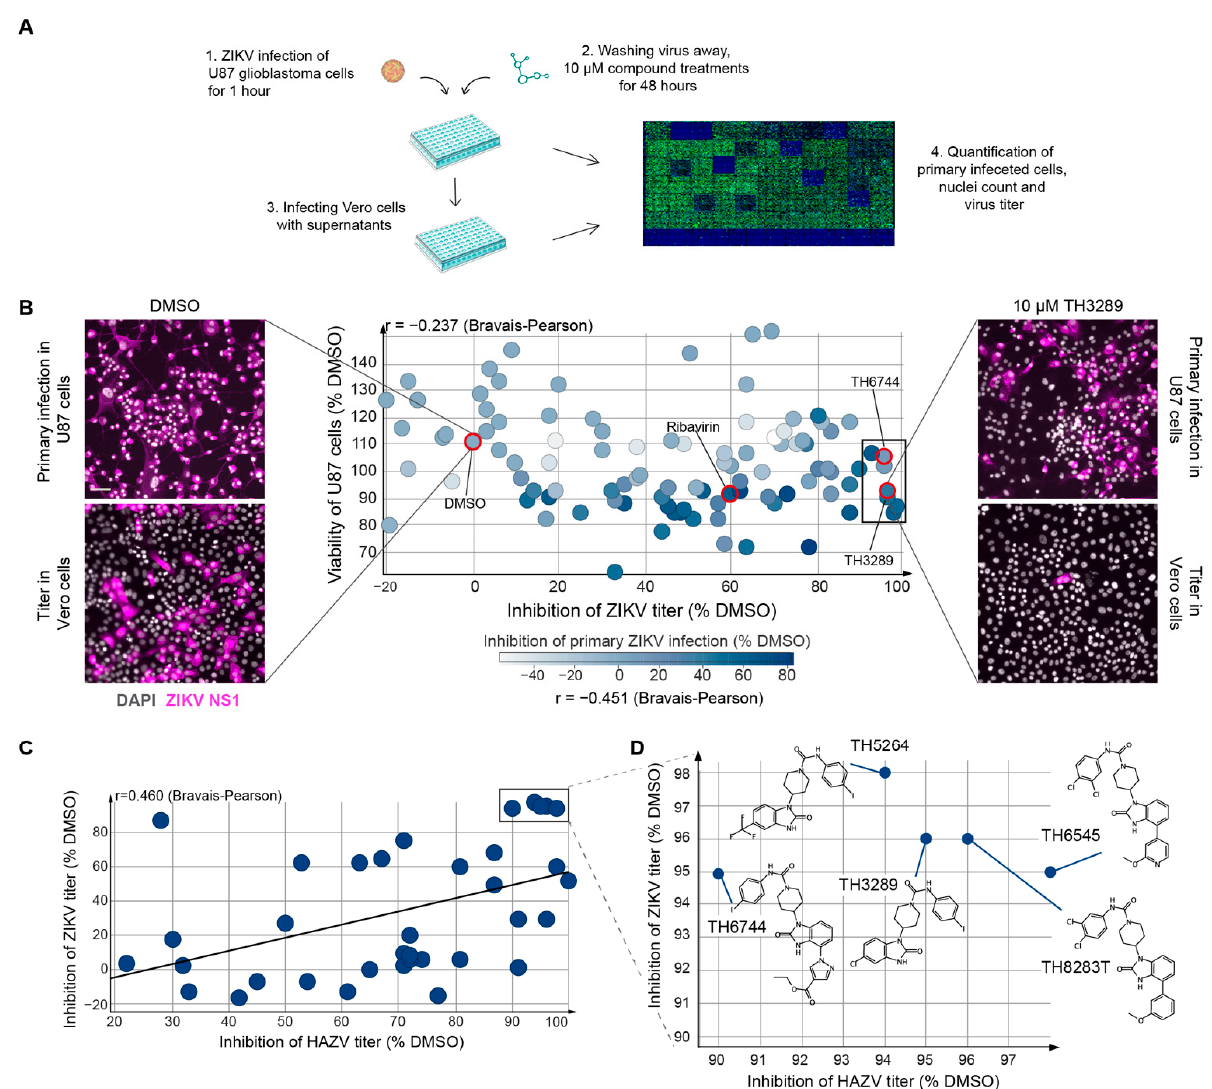
Figure 1. Image-based screening on Zika virus (ZIKV)-infected cells identifies TH3289 and TH6744 as active small molecule inhibitors against ZIKV. ( A ) Experimental workflow of phenotypic antiviral testing of small molecule compounds. Nuclei count was used as an indicator of cytotoxicity, viral antibody staining was quantified to assess the percentage of virus infected cells and virus titer was quantified by end-point dilution assay. ( B ) U87 cells were infected with ZIKV (MOI 10) and treated with structural analogs of TH3289 at 10 µ M concentration for 48 h. Infected cells were stained for DAPI and ZIKV NS1 and analyzed by high-throughput imaging. Virus titers from supernatants were determined by end-point dilution assay and inhibition of viral titer was calculated relative to dimethyl sulfoxide (DMSO). Data are presented as a mean of two technical replicates per compound performed in n = 1 biological replicate. Representative images from ZIKV-infected U87 cells treated with DMSO or TH3289 (upper image panels; Scale bar equals 100 μ m) and corresponding example of titrated ZIKV from the end-point dilution assay (lower image panels) are shown. DAPI in grey, ZIKV NS-1 in magenta. ( C ) The inhibition of viral titers of Hazara virus (HAZV) and ZIKV from both assays was correlated. In the HAZV assay, SW13 cells were infected with HAZV (MOI 10) and treated with 10 μ M of compounds from the in-house library for 24 h. Virus titer from supernatant was determined by end-point dilution assay. Cells were stained for DAPI (in blue) and HAZV NP (in green) and analyzed by high-throughput imaging. Data are presented as a mean of two technical replicates per compound performed in n = 1 biological replicate. ( D ) Chemical structures of top hits from ZIKV and HAZV antiviral screenings and their respective inhibition on viral